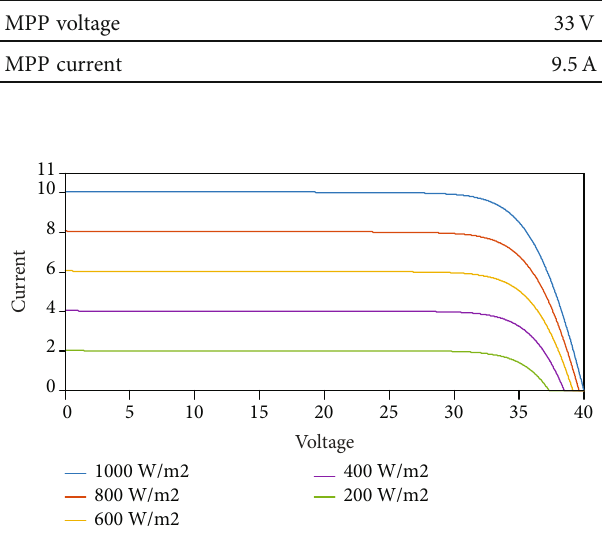
Figure 2: The current-voltage characteristic curve of PV